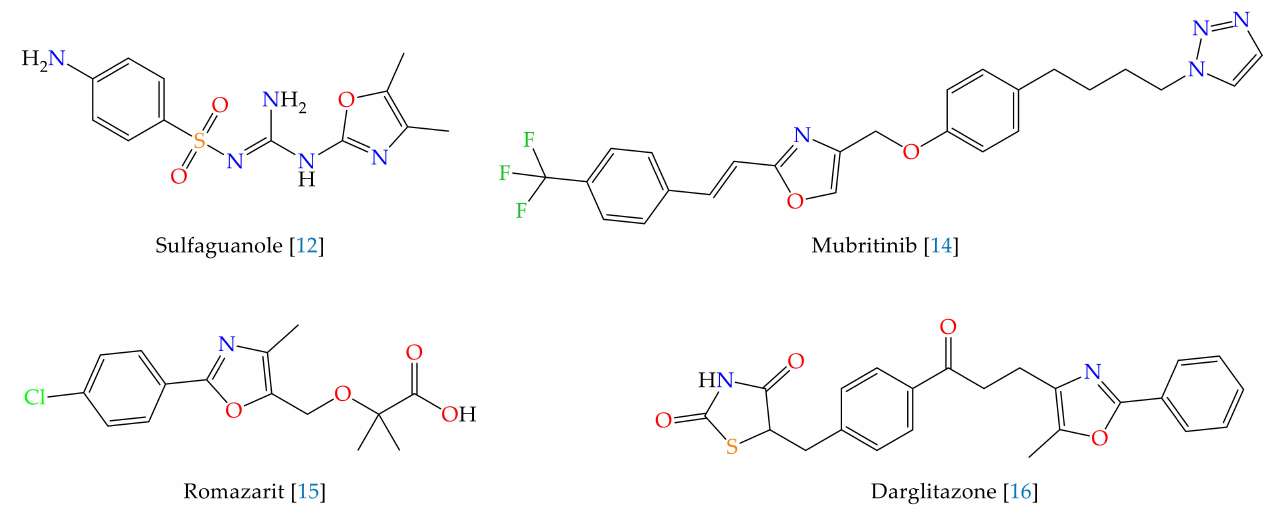
Figure 2. Structures of some representative bioactive synthesized compounds containing 1,3-oxazole